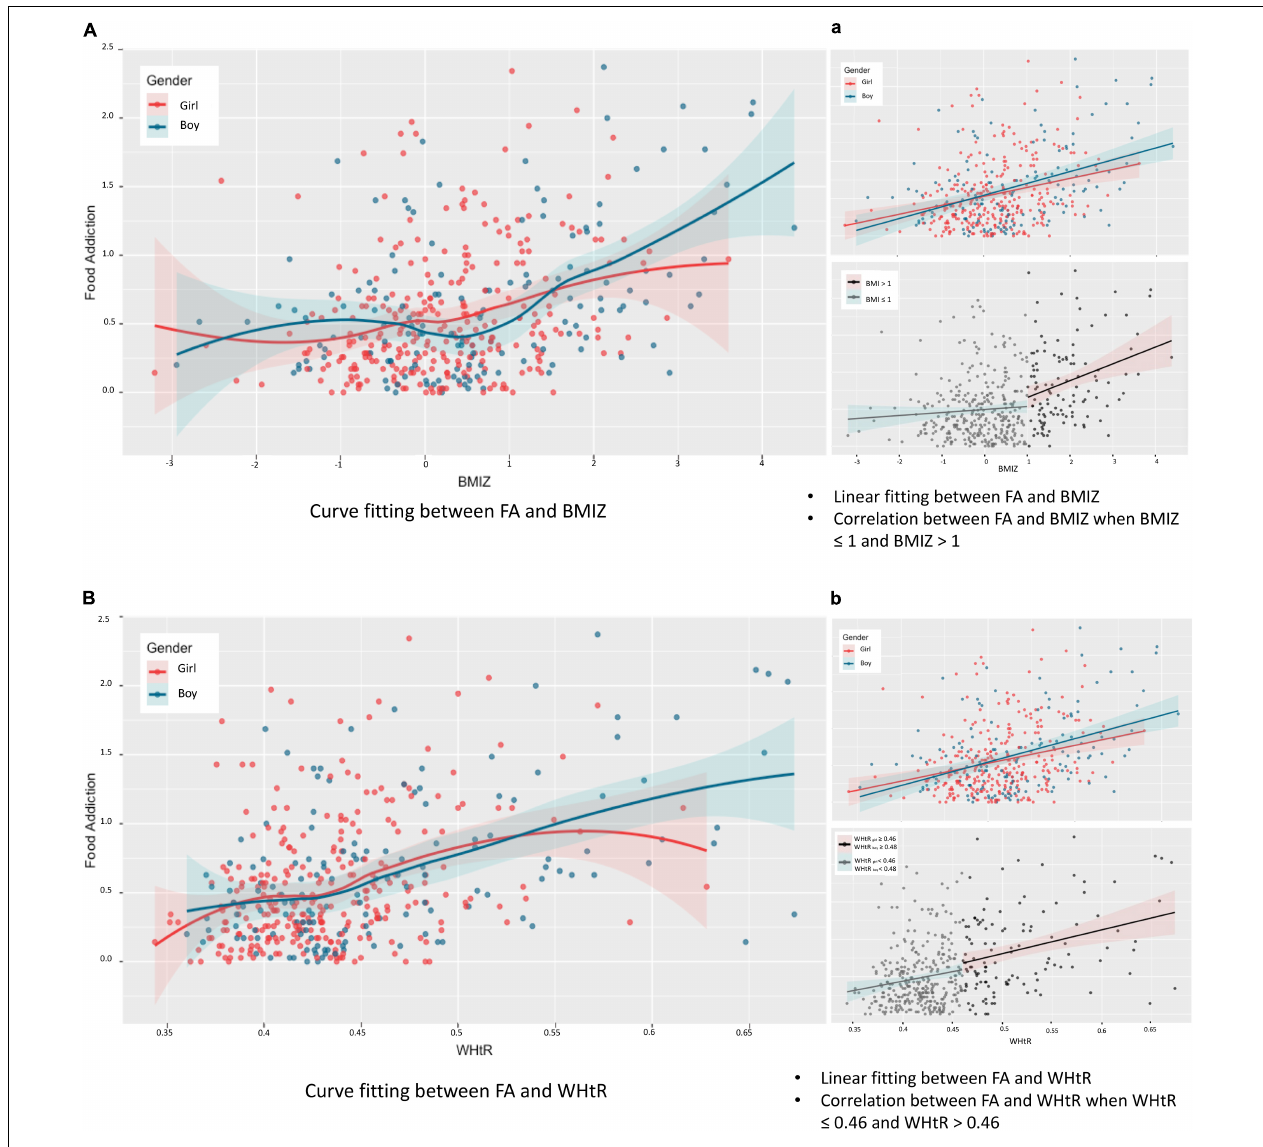
FIGURE 3 | Relationship between food addiction and weight status. BMIZ, body mass index Z score; WHtR, waist-to-height ratio. Partial correlation analysis (controlling for gender): r FA − BMIZ = 0.341 (95% CI = 0.248–0.435), p < 0.05. No interaction effect of gender was found between the association of FA and BMIZ ( F = 0.829, p = 0.775). Spearman relationship: r Boy = 0.362 (95% CI = 0.215–0.494), p < 0.05, r Girl = 0.274 (95% CI = 0.164–0.387), p < 0.05 (Aa) . Partial correlation analysis (controlling for gender): r FA − WHtR = 0.391 (95% CI = 0.288–0.484), p < 0.05. Interaction effect of gender was found between the association of FA and WHtR ( F = 2.158, p < 0.05). Spearman relationship: r Boy = 0.420 (95% CI = 0.283–0.541), p < 0.05, r Girl = 0.306 (95% CI = 0.191–0.418), p < 0.05 (Bb)